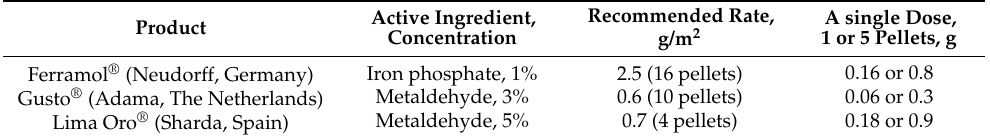
Table 1. Slug control measures used in treatments.